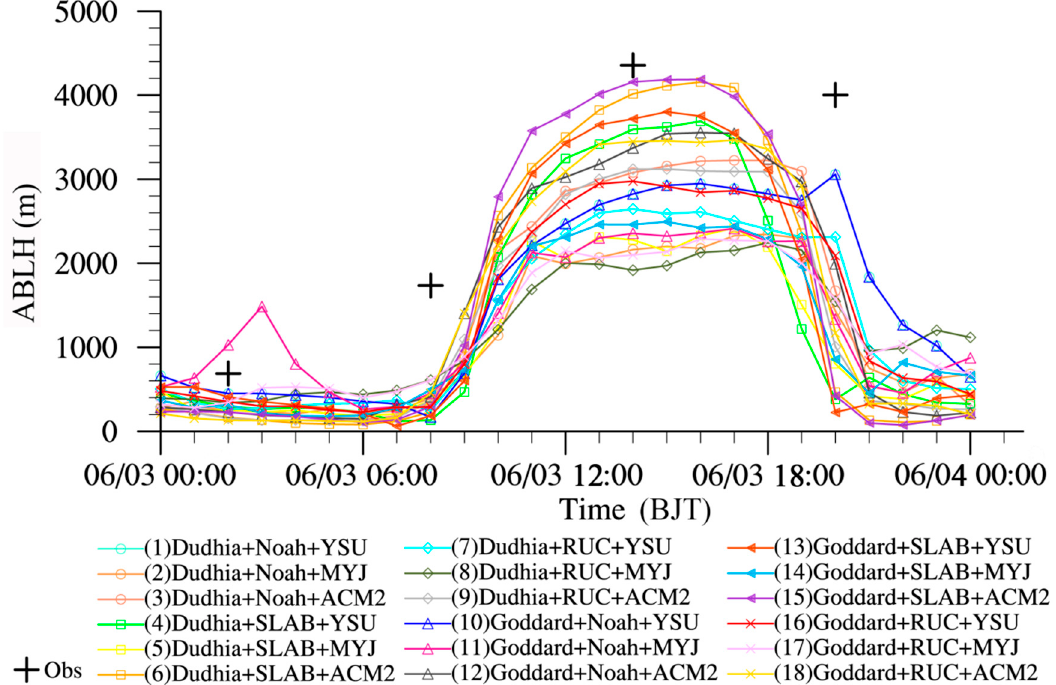
Figure 10. Numerical simulation of Minqin using different combinations of parameterization schemes and calculation of boundary layer heights with ERA-Interim model level data from 16:00 on 2 June, 2016, to 16:00 on 3 June, 2016.